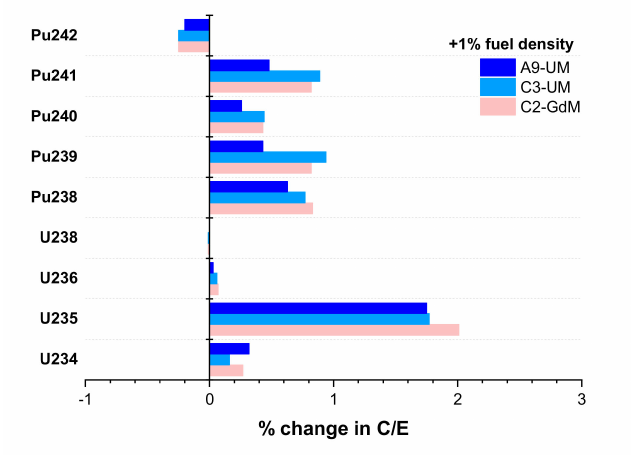
Figure 5. Change in U and Pu C/E isotope concentration ratios due to 1% change in fuel density for samples from assembly